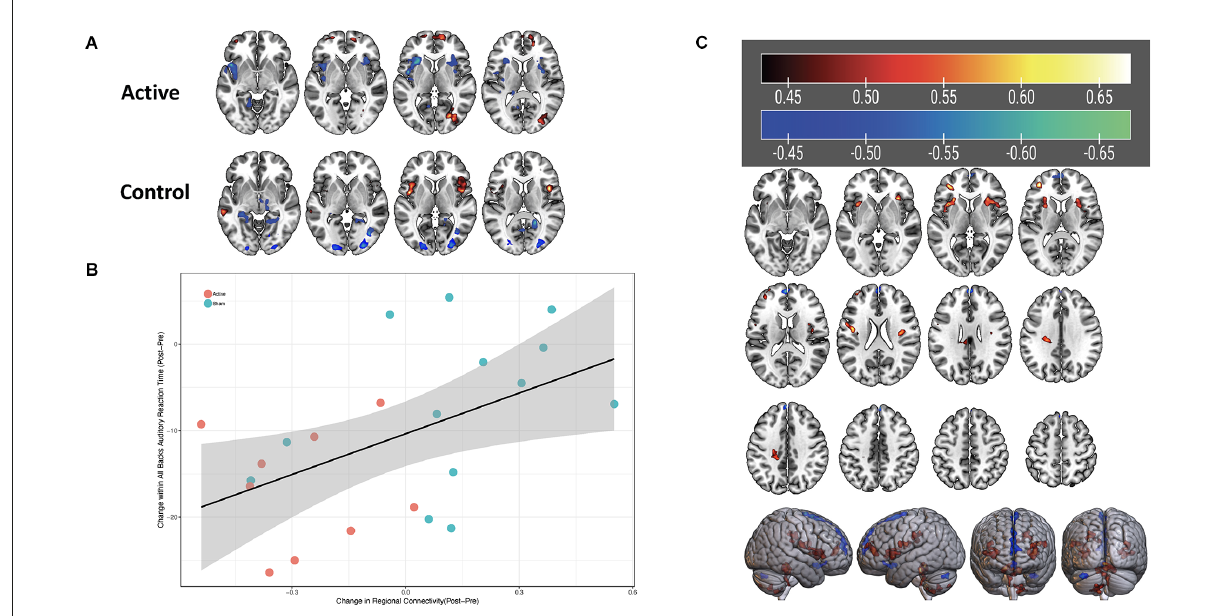
FIGURE6 (A) Change in connectivity of the right DLPFC from pre- to post-stimulation. Blue-green color indicates a reduction in connectivity, red-yellow color indicates increase in connectivity. (B) Scatterplot with linear fit line of change in connectivity between the right DLPFC and left anterior insula (x-axis) and change in reaction time on auditory stimuli for the N-back task (y-axis). Orange symbols indicate the active group; blue symbols represent the control group. Correlation value r = 0.5. (C) Significant correlation strengths between right DLPFC connectivity and auditory reaction time on the MMWM. Red-yellow colors in bilateral insula regions indicate positive correlated, i.e., faster (decreased) reaction times are associated with decreased connectivity between the right DLPFC and those